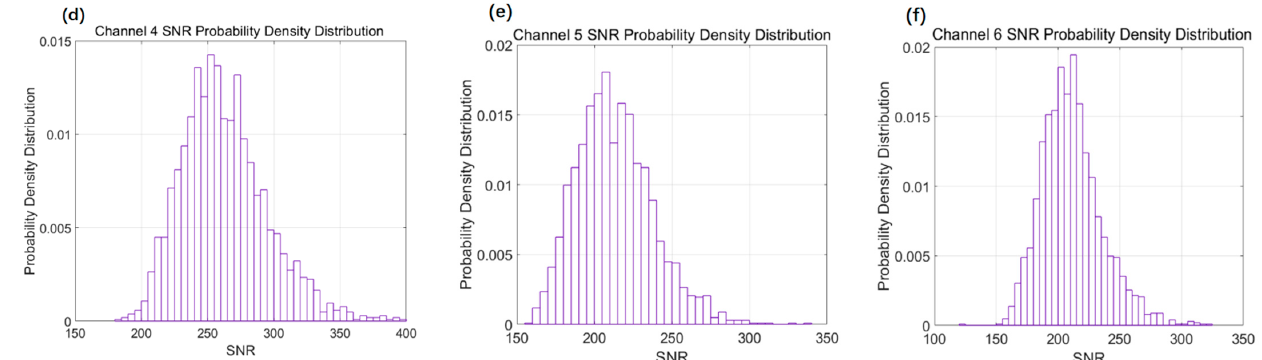
Figure 23. Probability density distribution of SNR after spatial pixel combination ( a ) Channel 1; ( b ) Channel 2; ( c ) Channel 3; ( d ) Channel 4; ( e ) Channel 5; ( f ) Channel 6. According to the output signal of DGSS illuminated by integrating sphere light source and the spectral radiance of integrating sphere light source, the radiation response